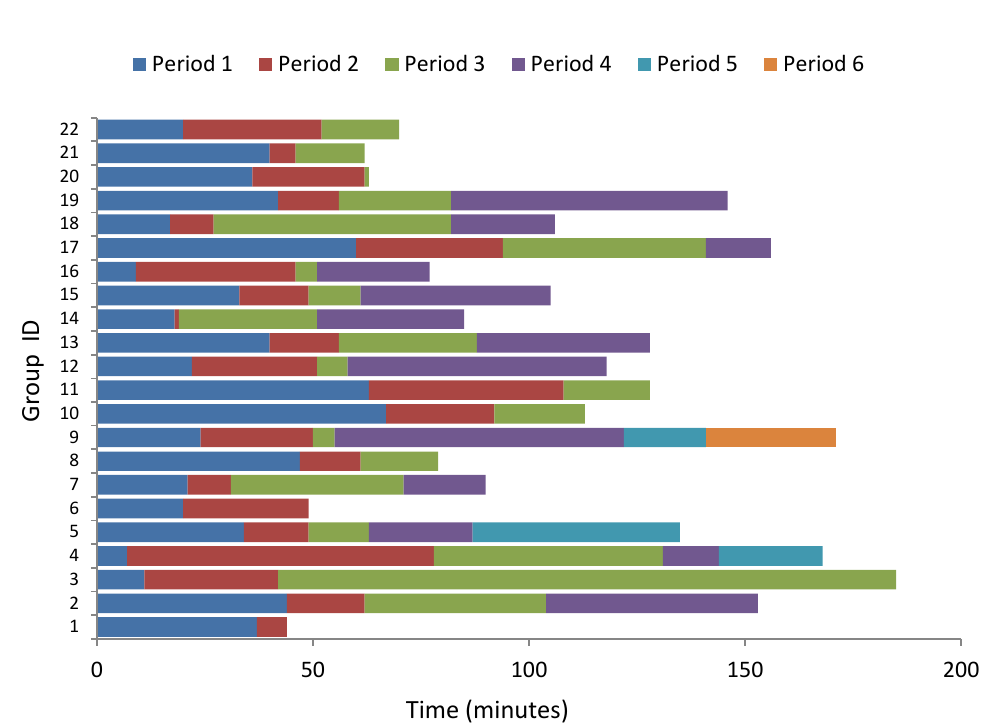
Figure 4 . Number of periods recorded in the 22 competitive groups assessed. Each color corresponds to a period where changes in membership